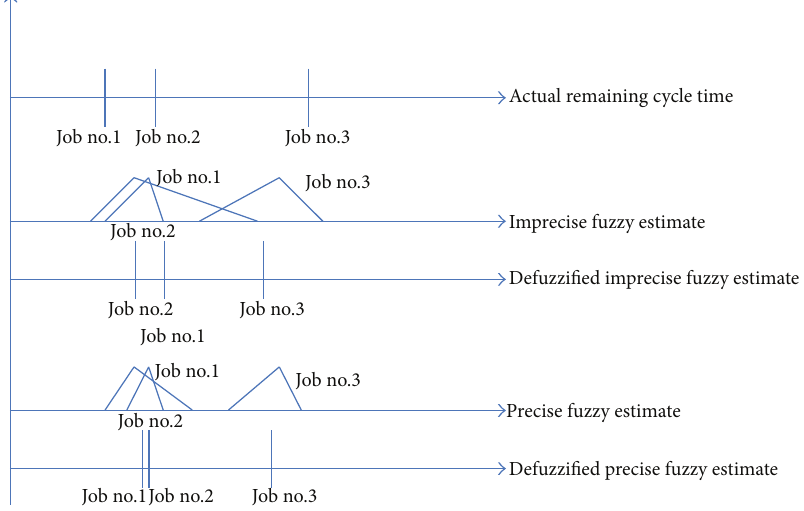
Figure 5: Precise remaining cycle time estimation eliminates